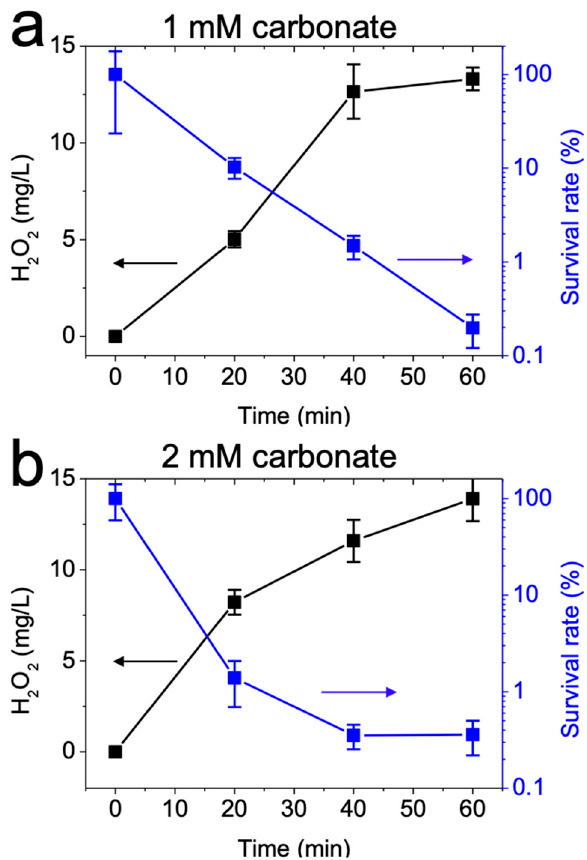
Figure 6. Effect of carbonate on hydrogen peroxide production or bacterial disinfection at ( a ) 1 mM or ( b ) 2 mM. Conditions: 3 g GAC as cathode under 100 mA current, 0.2 mM FeSO 4 , 10 8 CFU/mL E. coli . Carbonate concentration was indicated. Reaction solution was adjusted to pH 7 after addition of carbonate ions.